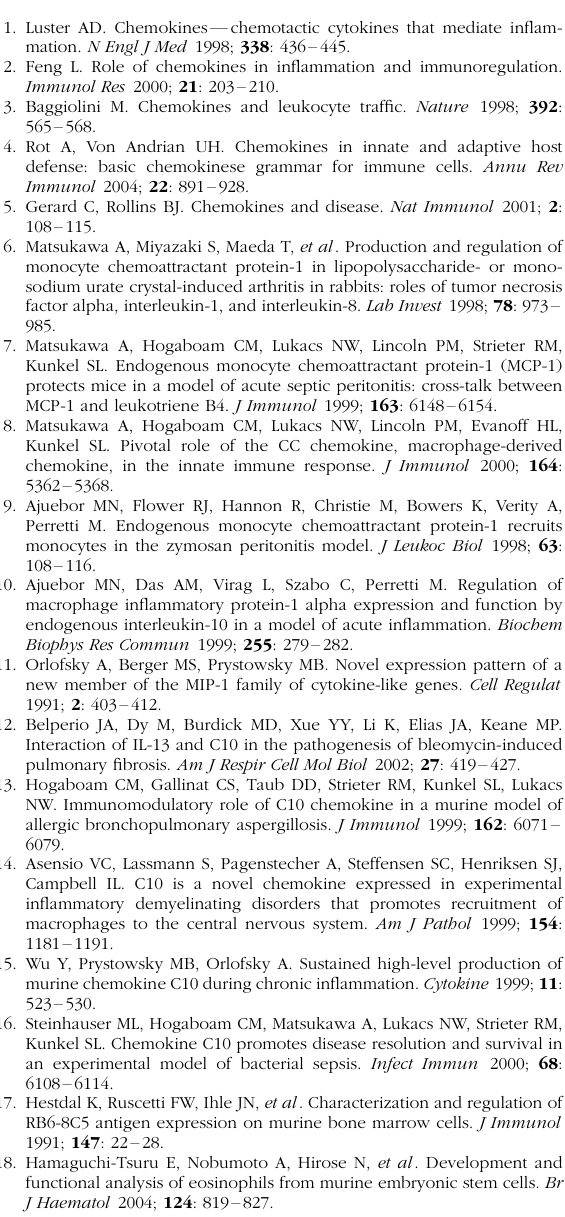
FIG. 7. Peritoneal CCL6 level in granulocyte-depleted mice. Granulocytes were depleted using RB6-8C5 monoclonal antibody. As a control, isotype-matched mouse IgG was used. At indicated intervals after thioglycollate injection, mice were euthanized and the peritoneal fluids were har- vested (each group, 10 mice). CCL6 levels in the peritoneal fluids were measured by